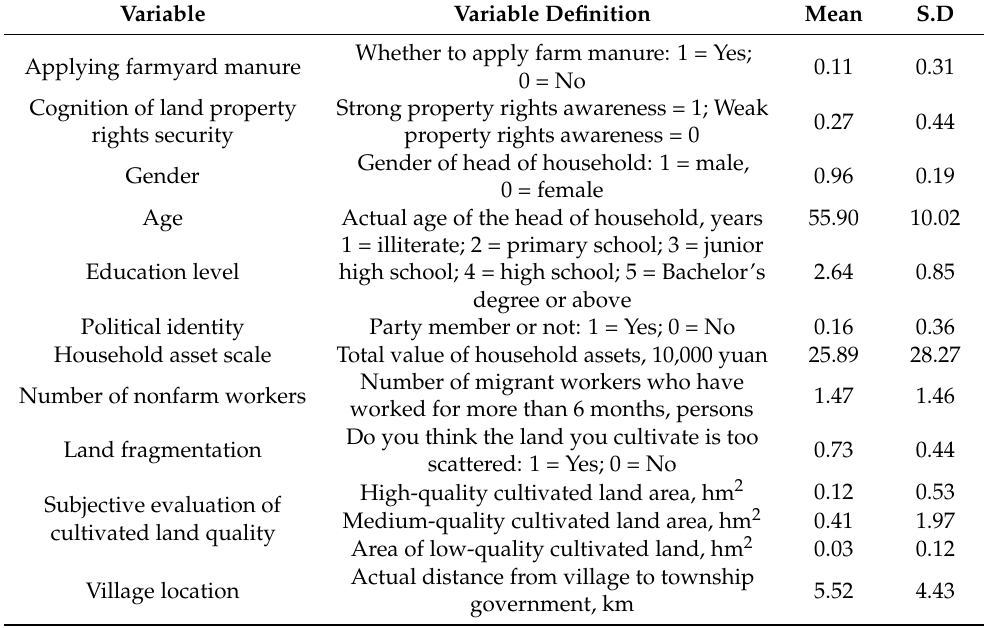
Table 1. Variable definition and statistical